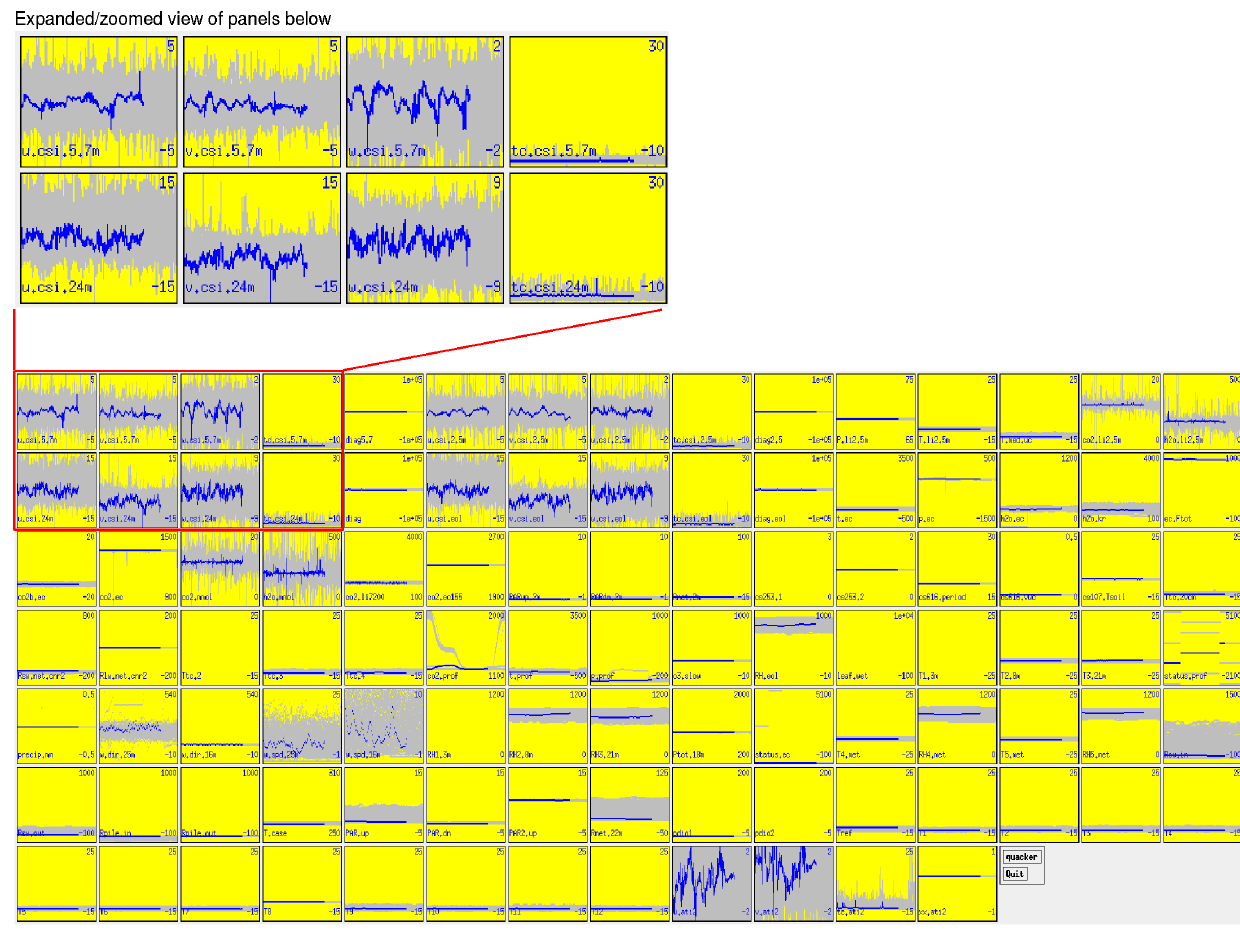
Figure 3. Screenshot of data monitoring software (cockpit) from 7 February 2014. Each box shows data from an individual sensor where the blue line is the current, real-time data being collected and the gray background is the trace of data collected since the cockpit session was initiated. The upper set of inset panels offers an enlarged view of the eight panels outlined in red in the upper left-hand corner of the cockpit window; here, the wind components and temperature measured by two CSAT3 sonic anemometers with base variable names u , v , w , and tc are